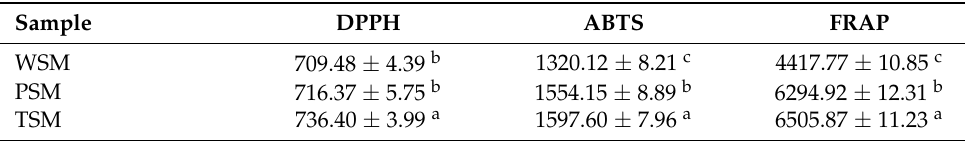
Table 4. Antioxidant activity of sunflower meal